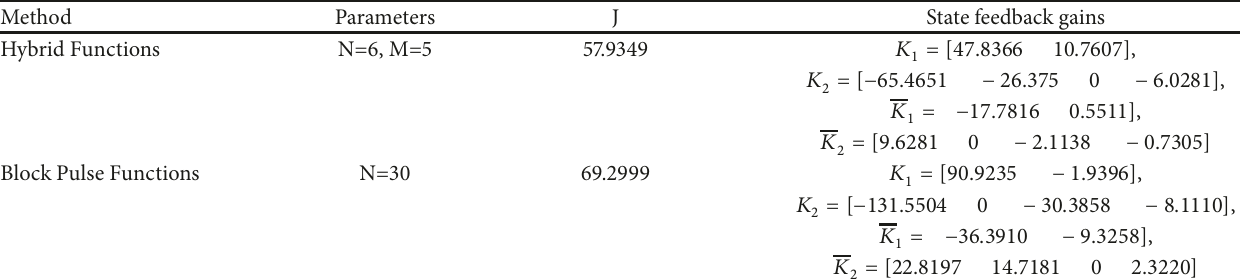
Table 2: Hybrid functions and block pulse functions open loop and closed loop results for Example 2.